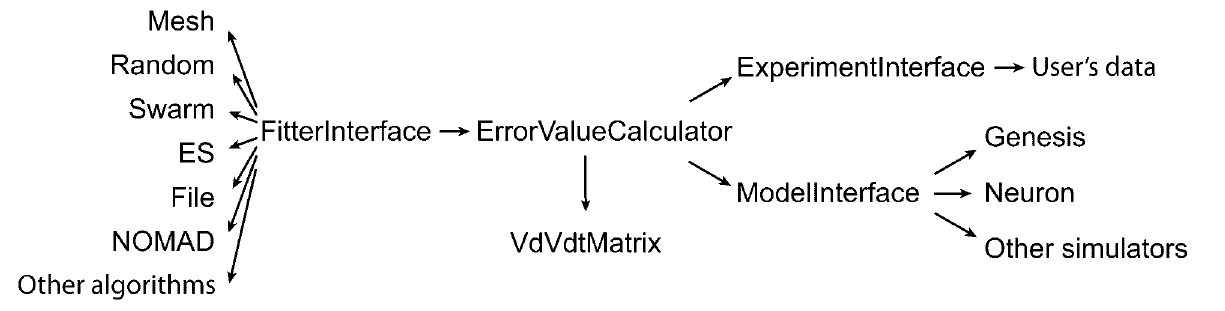
Another possibility is to split the parallelization at the level of the run parameters, this way one can run different stimulation protocols of the model on different CPU nodes. This only makes sense if one wants to run the model with a large number of different protocols, and if this num- ber is a multiple of the number of processor nodes on the computer